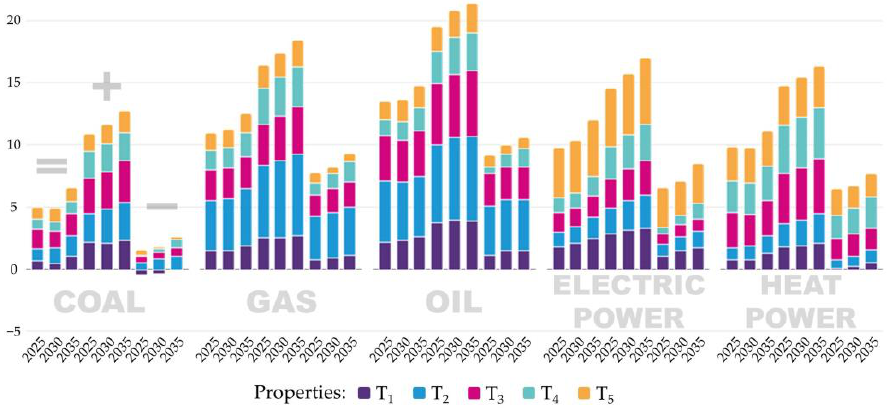
Figure 9. Industry’s scenario coefficients of the development of properties of the Ural LFEC at three time intervals.